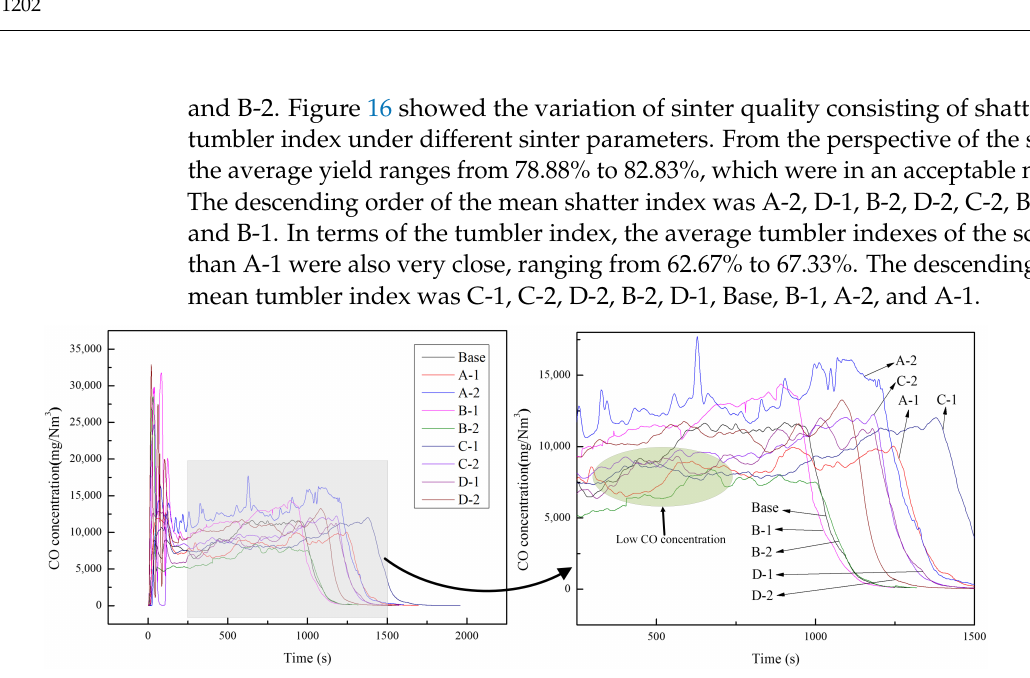
Figure 14. Influences of the sinter parameters on CO emission concentration.